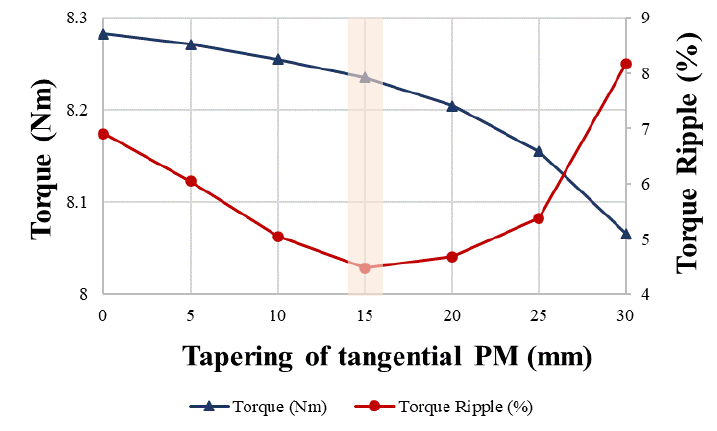
Figure 22. Torque and ripple according to tapering of tangential PM.